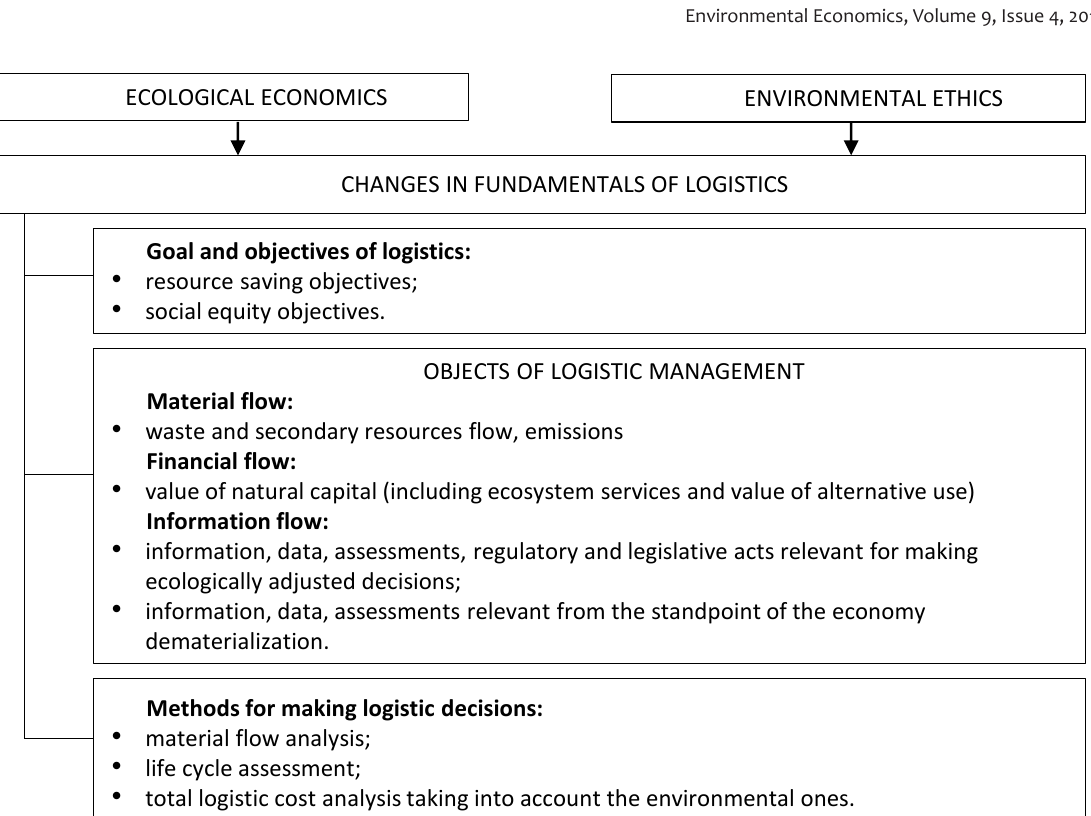
Figure 1. Directions and content of ecologically related transformation of logistics